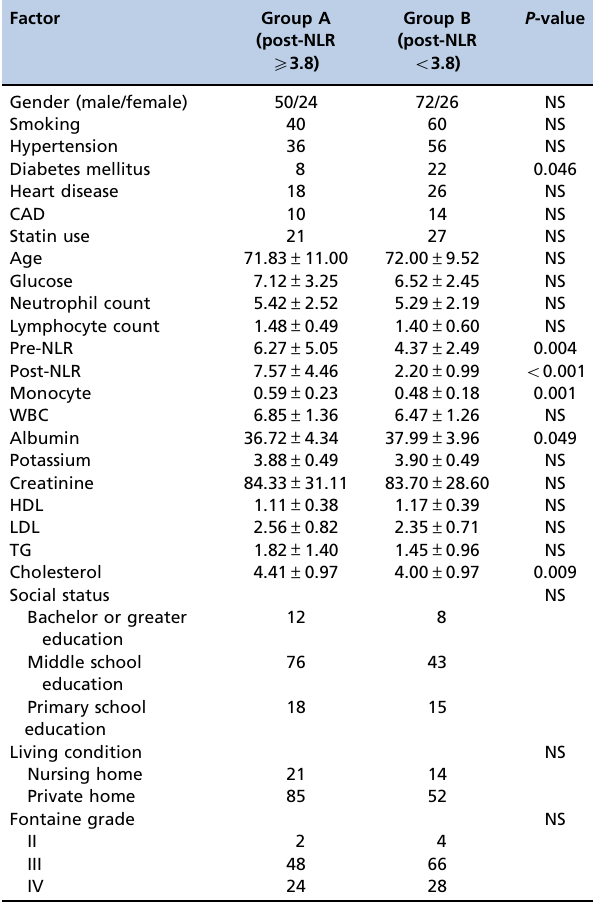
Table 1 - Baseline characteristics of 172 CLI patients compared according to post-NLR.